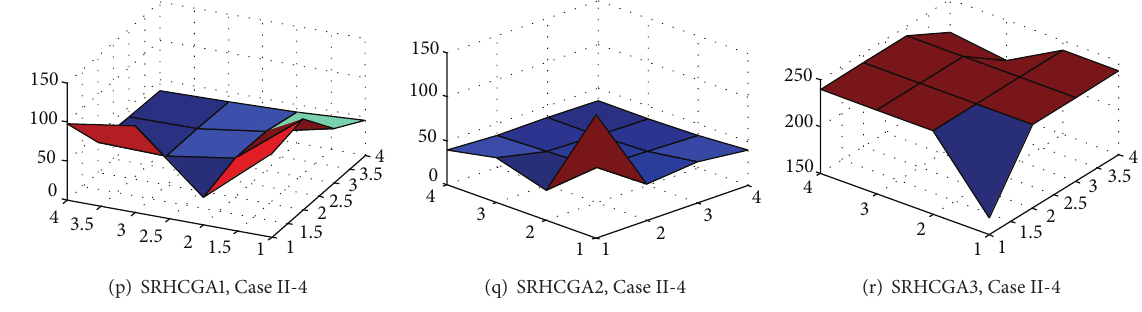
Figure 14: Influence of 𝑁